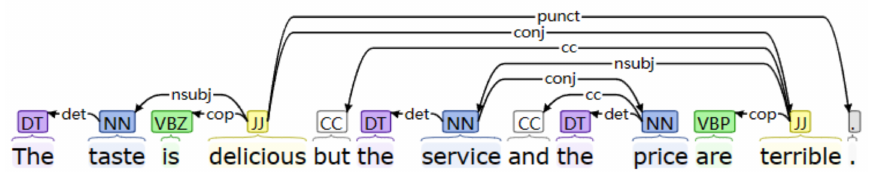
Figure 2. The result of dependency tree parses.